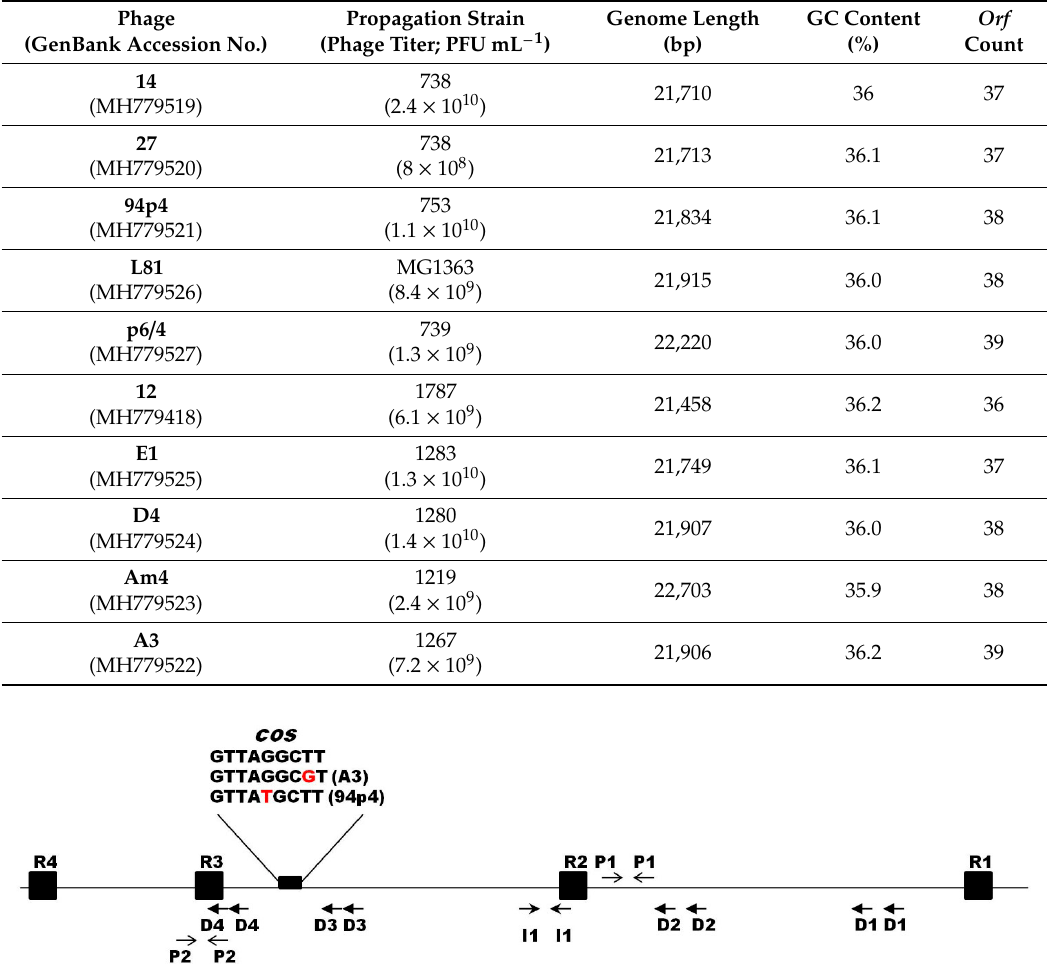
Table 4. Characteristics of phage genomes based on sequencing data.